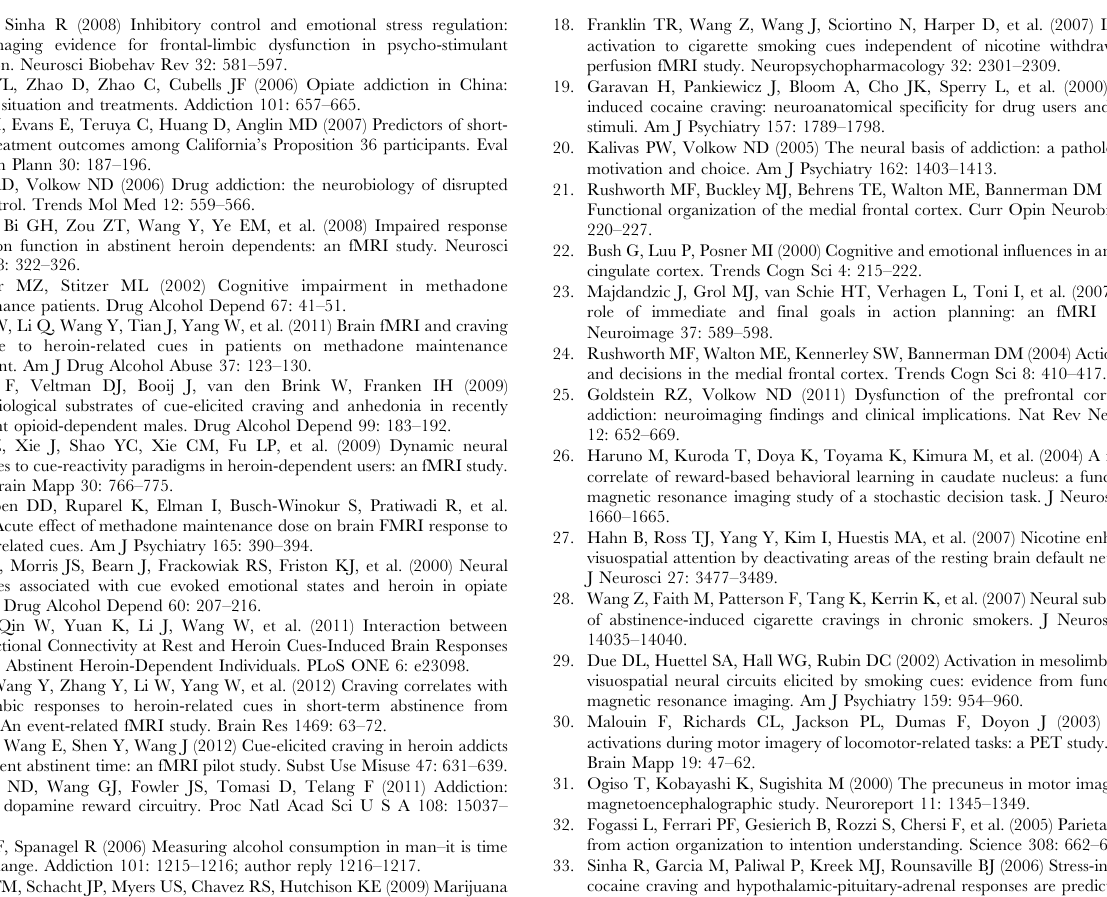
Figure S1 Correlation maps between signal changes in the left MPFC and IPL, which were significantly activated among heroin-dependent patients by heroin- related cues, and the abstinence duration ( P , 0.05, corrected for Monte Carlo simulations; r : correlation coefficient). Table S1 Activated brain regions for the SA group in response to heroin-related vs. neutral